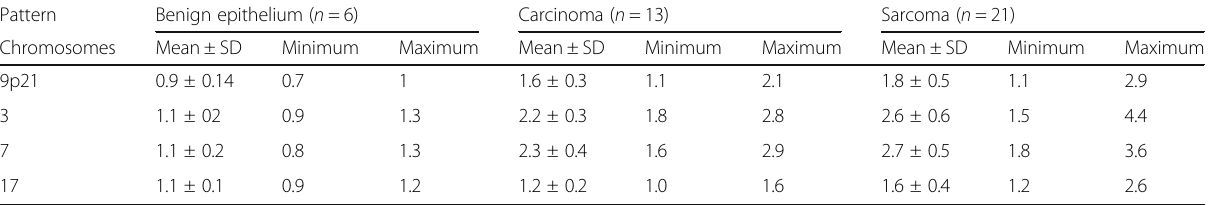
Table 2 Comparison of chromosomal aberrations among benign, carcinomatous, and sarcomatous components Pattern